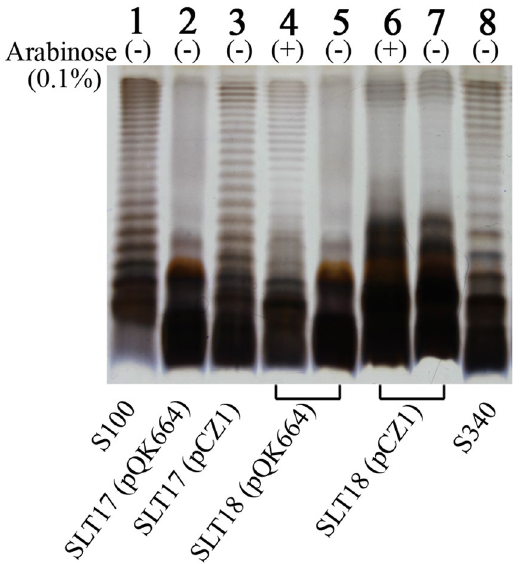
Figure 3. LPS phenotypes of the vaccine strains. LPS samples extracted from Salmonella Typhimurium wild-type S100 (lane 1), SLT17 (pQK664) (lane 2), SLT17 (pCZ1) (lane 3) and SLT18 (pQK664) grown with arabinose (lane 4) or without arabinose (lane 5), SLT18 (pCZ1) grown with arabinose (lane 6) or without arabinose (lane 7) and Salmonella Choleraesuis S340 (lane 8) were visualized by silver staining following PAGE. Each lane corresponds to LPS from 10 8 bacteria.